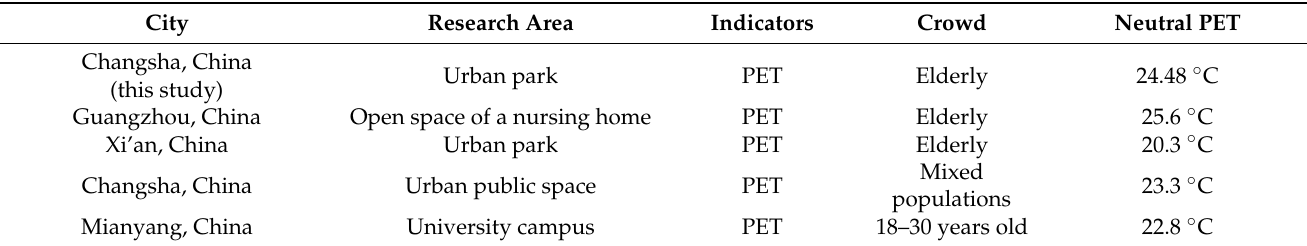
Table 8. Comparison of summer Neutral PET in different cities.